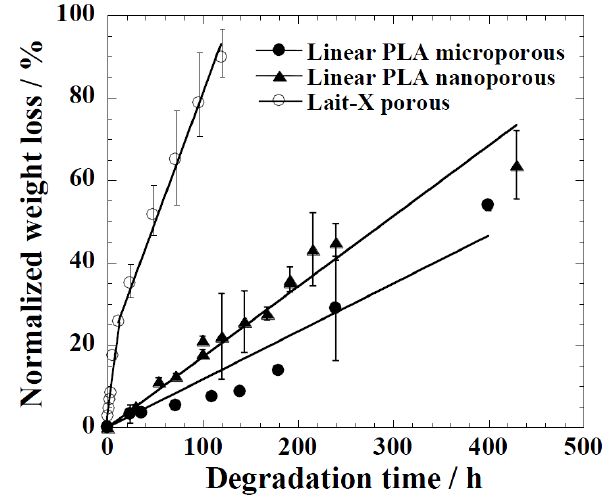
Figure 9. Normalized weight loss of linear polylactide (PLA) having nanoporous and microporous structures, and Lait-X having a porous structure.